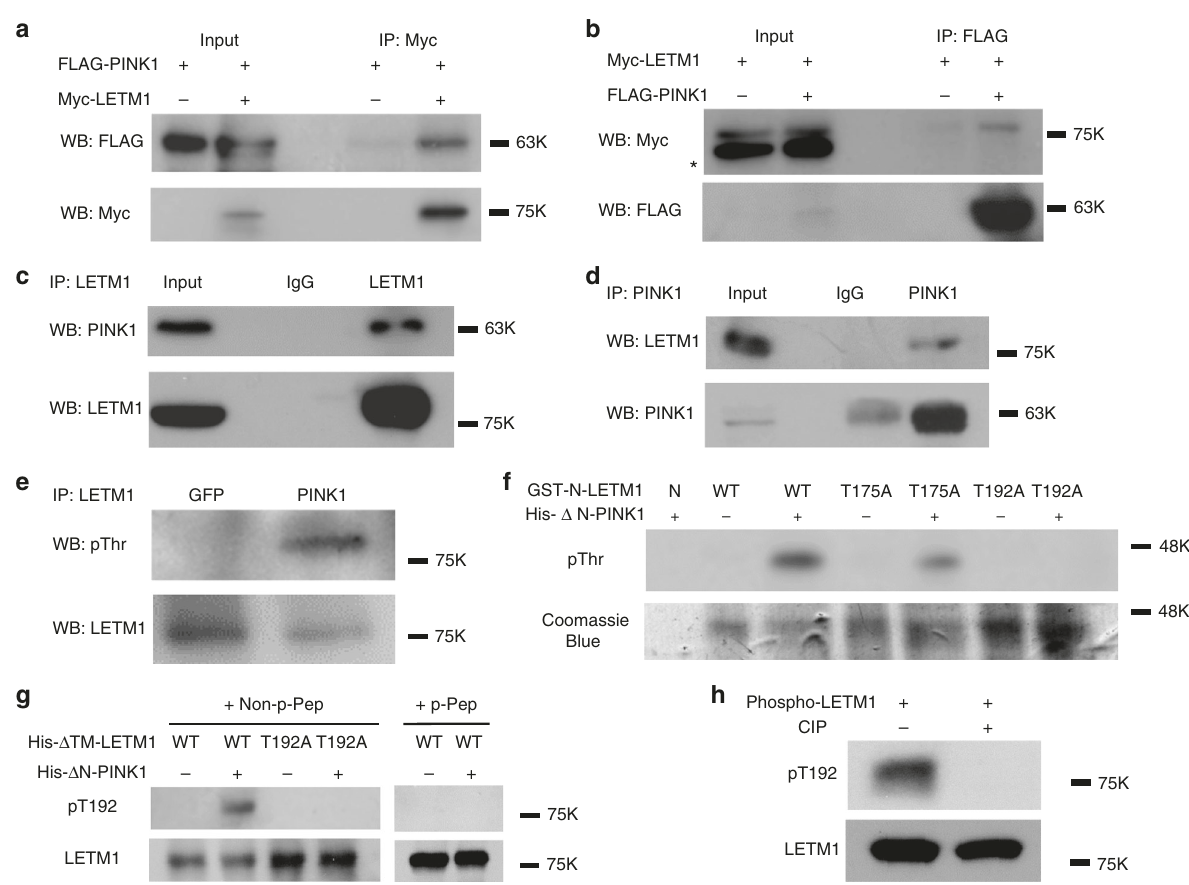
Fig. 1 PINK1 interacts with and phosphorylates LETM1. a Expressed PINK1 interacts with LETM1. HEK293 cells were co-transfected with p3xFLAG-CMV- PINK1 and pCMV-3Tag-2a LETM1 (Myc-tag) for 1 day. Myc-LETM1 was IPed from cell lysate with anti-Myc antibody and probed with anti-FLAG antibody by WB. The membrane was reprobed with anti-Myc antibody. b Inversely to a , FLAG-PINK1 protein was IPed with anti-FLAG antibody and probed with anti-Myc and Anti-FLAG antibodies. * is non-special band. c Endogenous PINK1 interacts with LETM1 in human post-mortem brain tissue. Brain lysate was IPed with control IgG or anti-LETM1. The precipitated proteins were probed with anti-PINK1 and reprobed with anti-LETM1 antibodies by WB. d Inversely to c IP was performed with control IgG or anti-PINK1, probed with anti-LETM1 and reprobed with anti-PINK1 antibody by WB. e PINK1 phosphorylates LETM1 at threonine residue(s) in vivo. HEK293 cells were transfected with GFP or pAdtrack-PINK1 for 1 day. LETM1 was IPed with anti-LETM1 antibody, probed with anti-phospho-Thr and reprobed with anti-LETM1 antibody by WB. f PINK1 phosphorylates LETM1 at Thr192 in vitro. Puri fi ed bacterial GST-N-LETM1 variants (resides 1 – 204) were subjected to an in vitro kinase assay with bacterial His- Δ N-PINK1 (residues 1 – 111 deleted) and probed with phospho-Thr antibody. Coomassie blue staining was performed as loading control for GST-N-LETM1. N: nil. g Bacterial His- Δ N-LETM1 variants were subjected to in vitro kinase assay with His- Δ N-PINK1 and probed for phospho-LETM1 utilizing the Thr192 (pT192) phospho-antibody. Samples were reprobed with anti-LETM1 for loading. h His- Δ N-LETM1 was incubated with His- Δ N-PINK1 in an in vitro kinase reaction to generate phospho-LETM1. Phospho-LETM1 was then treated without or with CIP for 2 h then probed with pT192 and reprobed with LETM1 antibody. All above experiments were replicated three